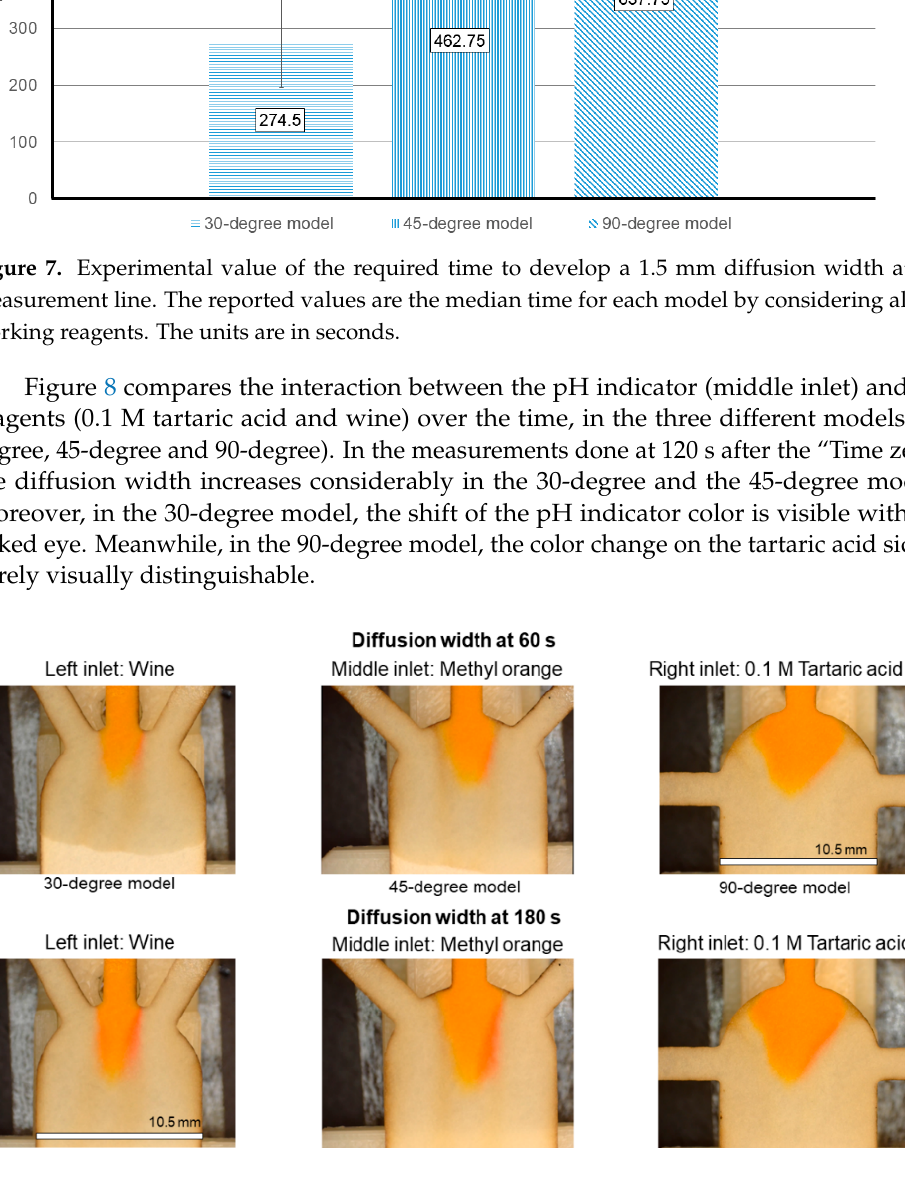
Figure 8. Diffusion widths at 60 s and 120 s after “Time zero” in paper strips with 30 ◦ , 45 ◦ and 90 ◦ of inlets’ angle. At all the cases, the wine is flowing through the left inlet and 0.1 M tartaric acid is entering through the right inlet. Scale = 10.5